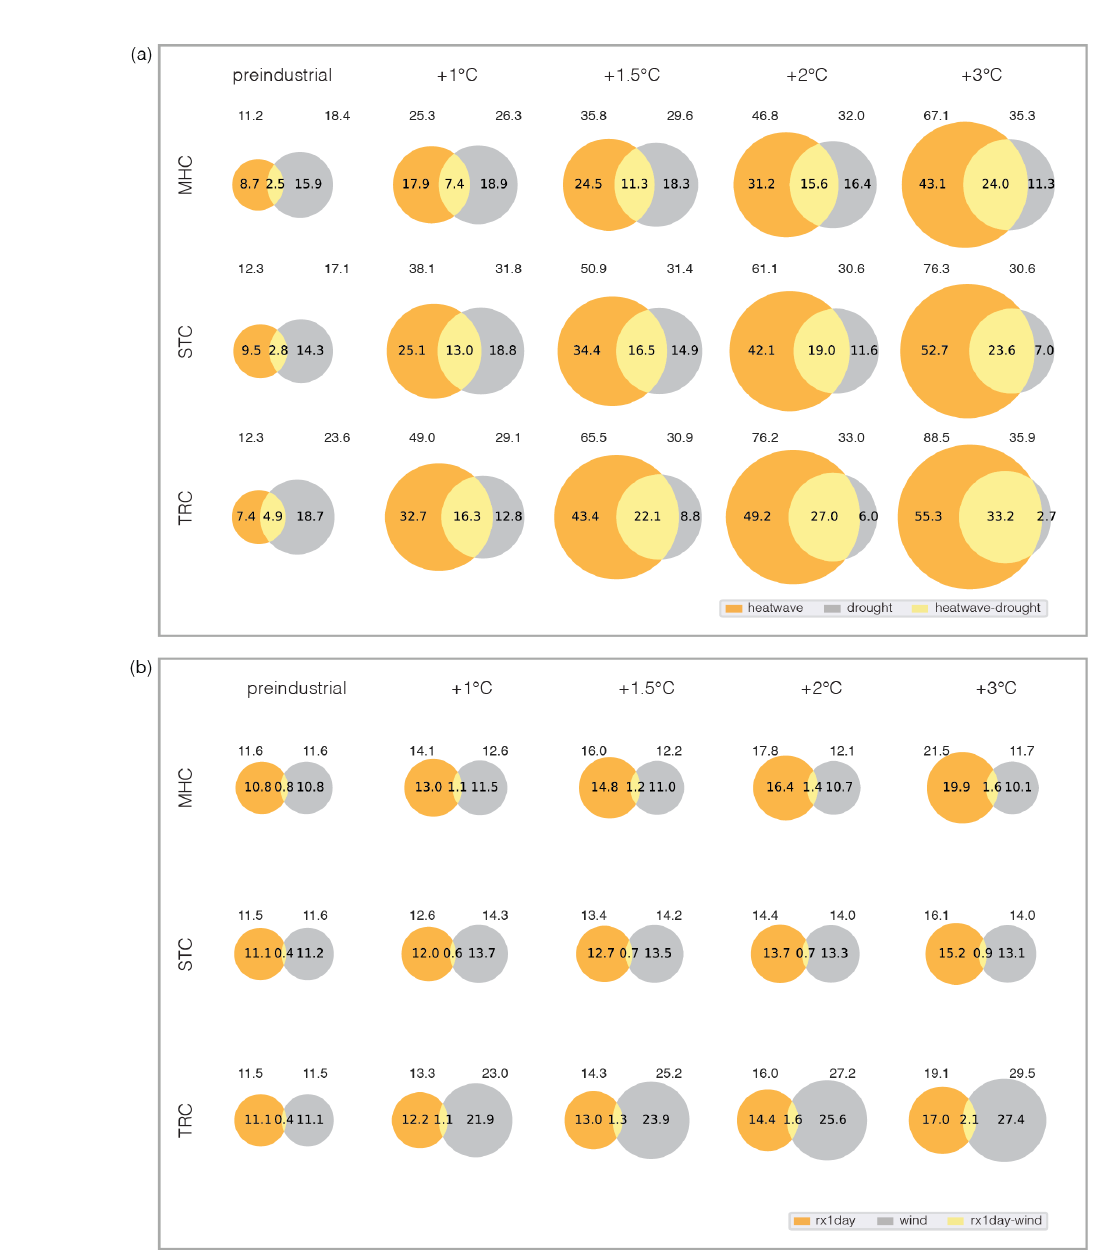
Figure 3. Venn diagrams of (a) heatwave–drought and (b) Rx1day–wind storm events at global warming levels. The values show the individual and concurrent frequency of events in MHC, STC and TRC in the pre-industrial period and at + 1, + 1.5, + 2 and + 3 ◦ C GWLs. Areas of the circles are proportional to the frequencies (%) and represent the multi-model mean. The numbers above the Venn diagrams represent the total share of individual events including the ones occurring during concurrent